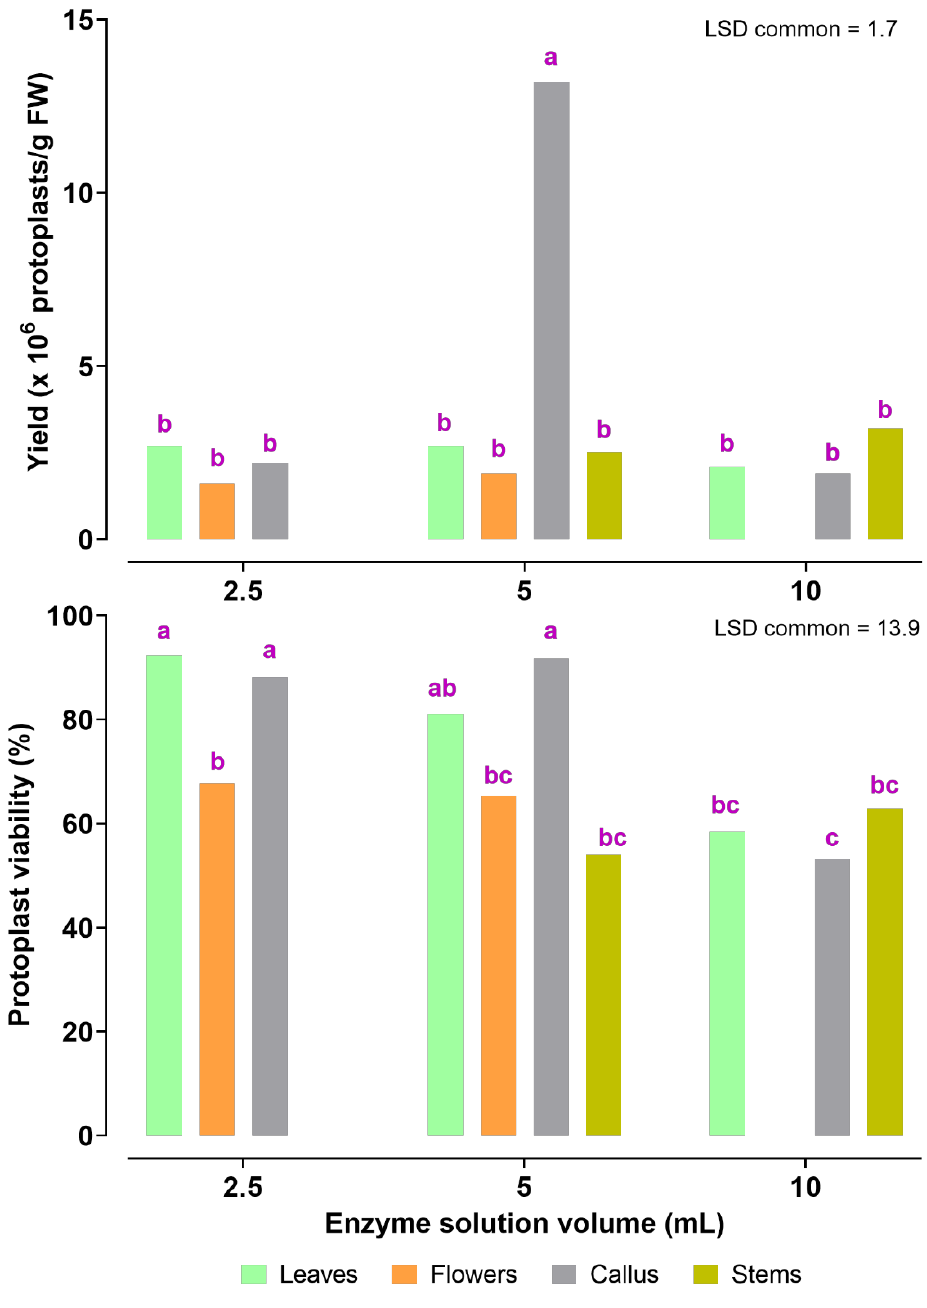
Figure 4. Effects of different volumes of enzyme solution (mL) on yield and viability of protoplasts isolated from different sources of J. sambac L. The upper left figure from leaf, the upper right one from flower, and the bottom figures are the ones from stem and callus tissues, respectively. Values represent the means of three replicates. Means labeled by the same letter are not significantly different at p < 0.05 according to the least significant difference test.